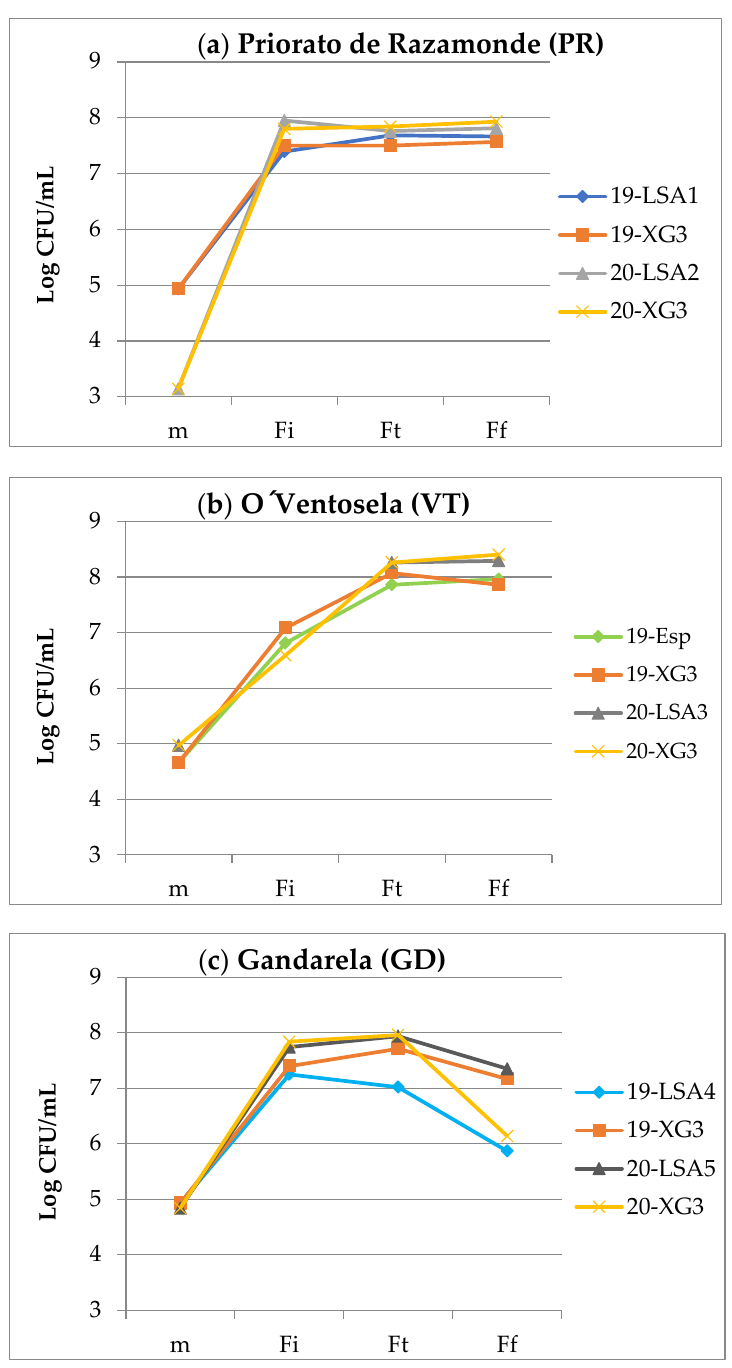
Figure 2. Evolution of yeast population in fermentations from ( a ) Priorato de Razamonde, ( b ) O´Ventosela, and ( c ) Gandarela in 2019 and 2020 campaign. M, must; Fi, Ft, and Ff are the initial, tumultuous and final stages of fermentation, respectively.